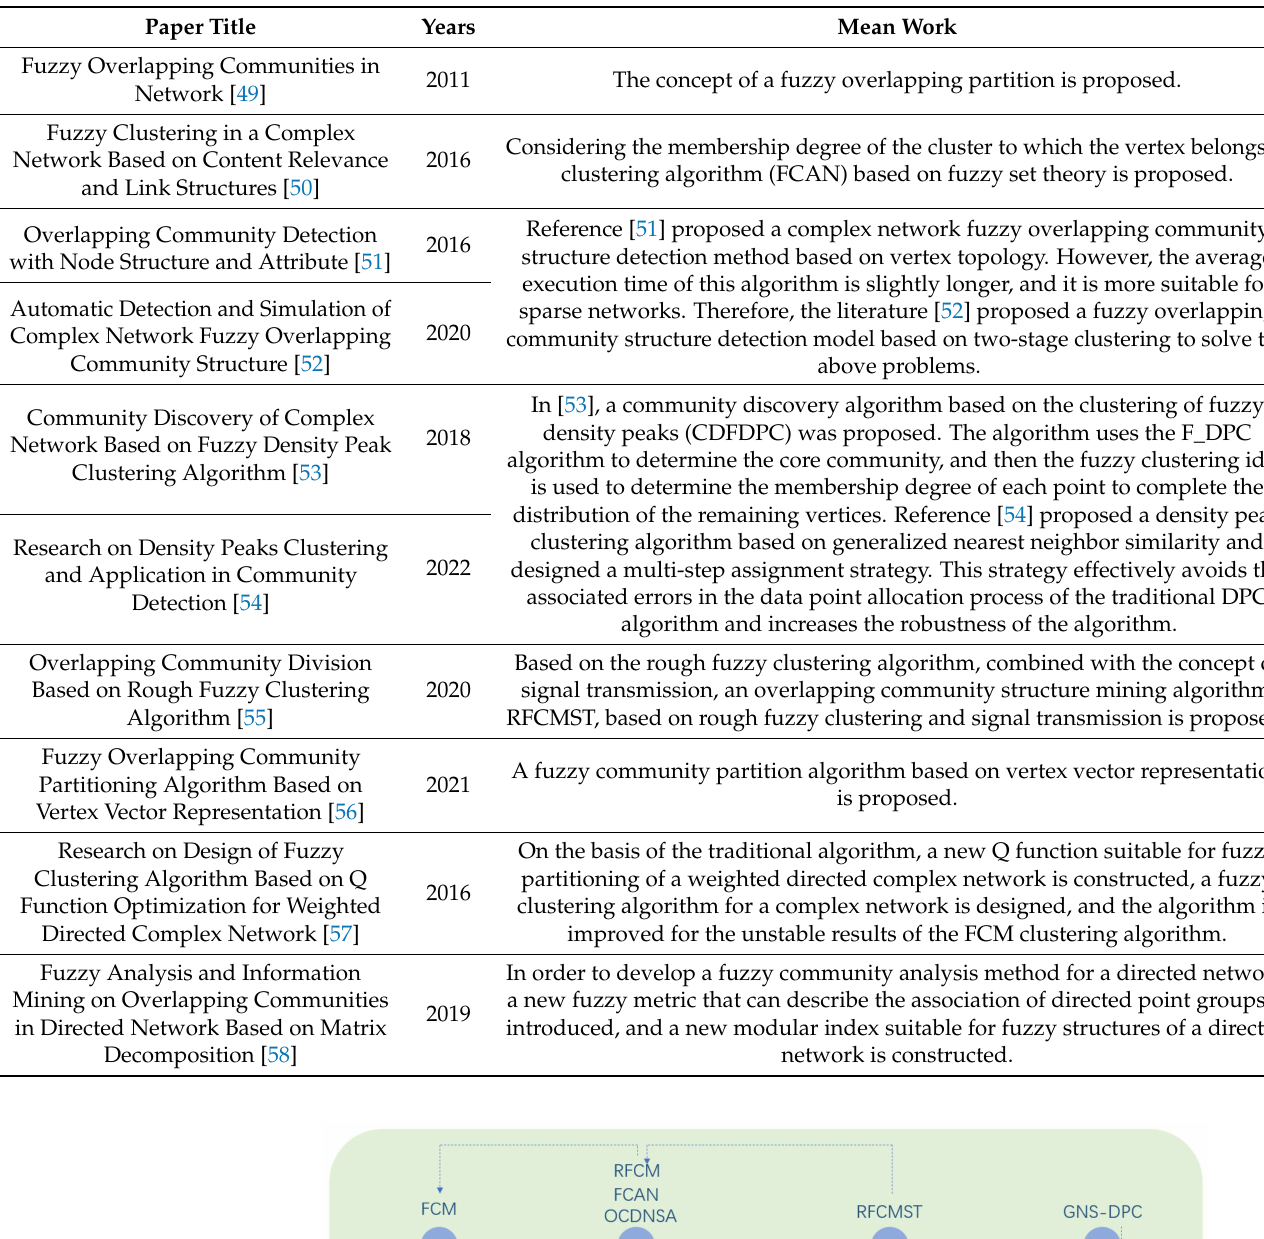
Table 4. Modeling of fuzzy set theory in community discovery.